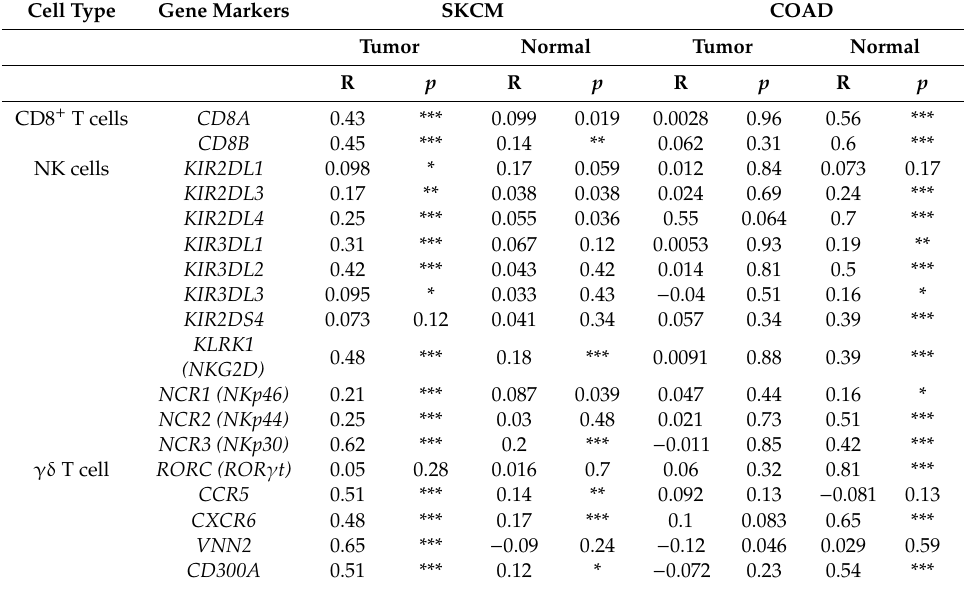
Table 2. Correlation between Ly75 and markers of anti-tumor e ff ector cells in Gene Expression Profiling Analysis